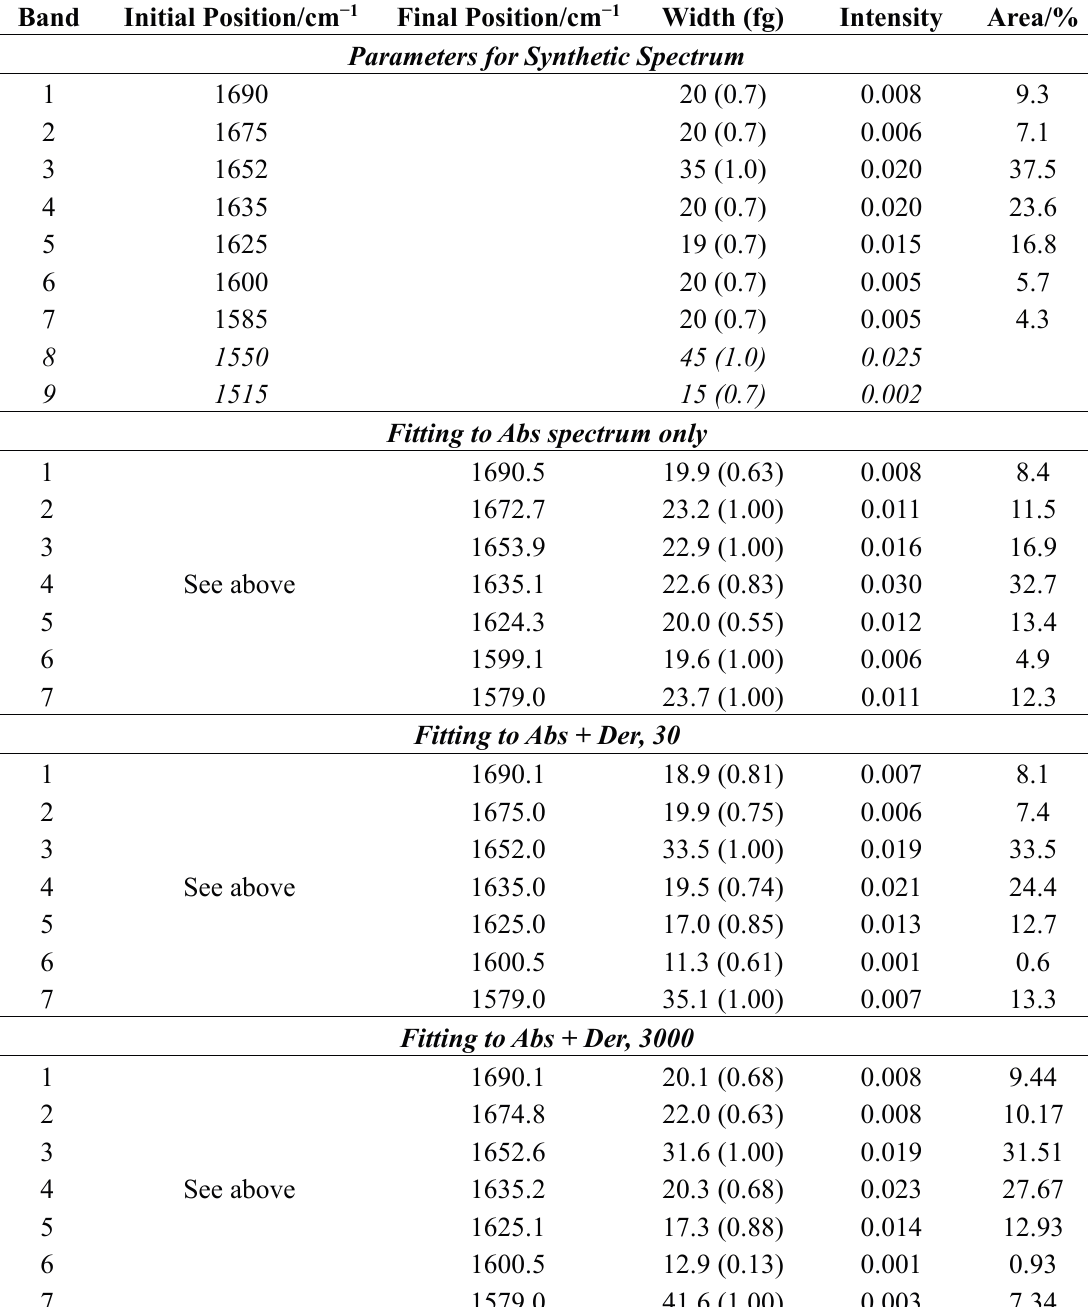
Table 1. Band parameters of a synthetic spectrum and of fitted spectra obtained upon standard fitting and co-fitting. Values in italics correspond to bands representing amide II and tyrosine vibrations which are outside the fitting range. The fg values denote the fractional contribution of the Gaussian lineshape to the overall lineshape. The initial value was 0.50 for all